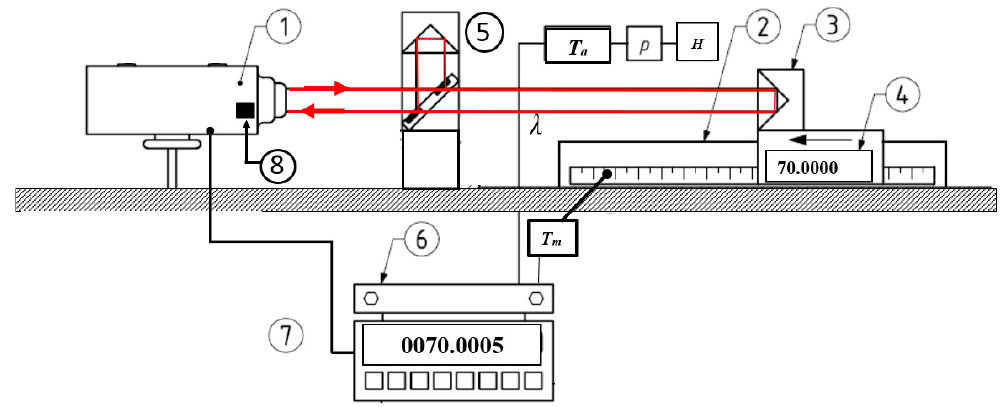
Figure 1. Example of a laser interferometer operation: 1: laser head, 2: slide way, 3: measurement corner-cube, 4: machine-axis reading, 5: beam splitter and reference corner-cube, 6: compensation unit, 7: displacement read-out and 8: photo-detector.